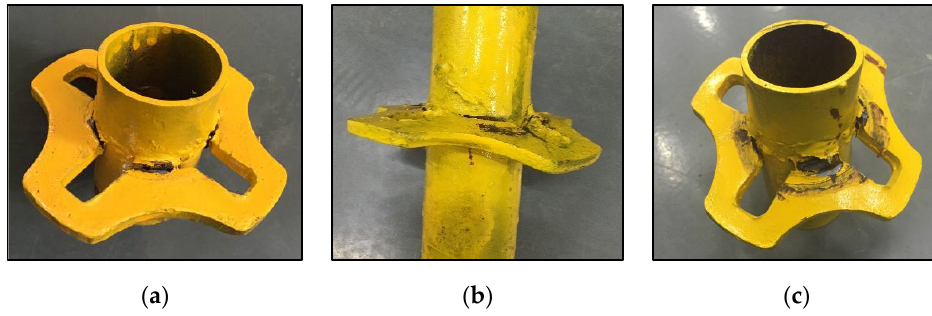
Figure 12. Shear failure mode of wheel: ( a ) Central pole; ( b ) side pole; ( c ) corner pole.